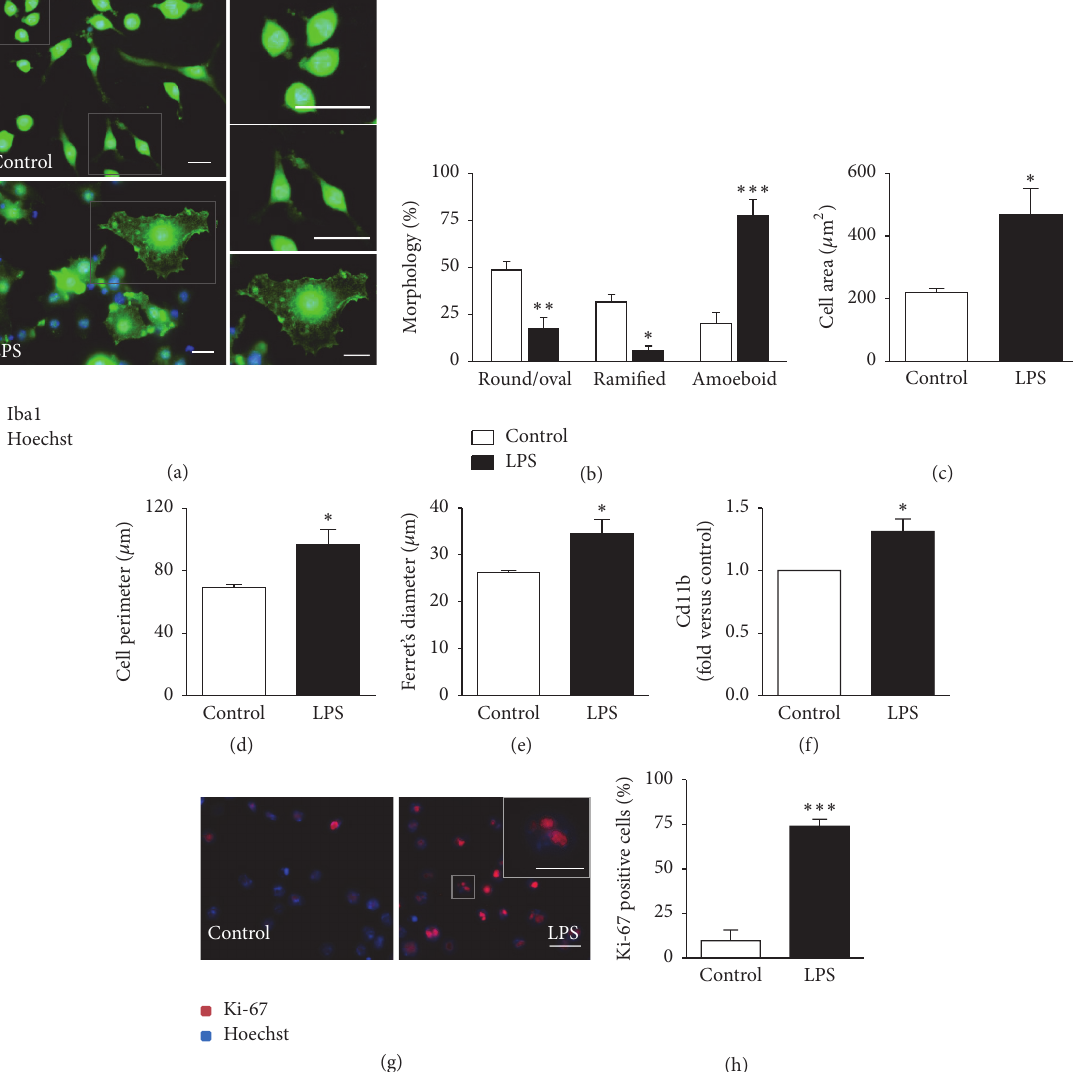
Figure 2: M1 polarized N9 microglia display amoeboid morphology, together with increased cell area, perimeter, and Feret’s diameter, while showing increased proliferation rate based on the high representation of CD11b and Ki-67 positive cells. Morphological analysis and detection of Ki-67 in the nucleus were performed by immunocytochemistry using anti-Iba1 and anti-Ki-67, respectively, as indicated in Materials and Methods. For morphology, representative results of one experiment are shown (a) and quantified as the percentage of cells with different morphologies, namely, round/oval, ramified, and amoeboid (b). Evaluation of cell area (c), perimeter (d), and Feret’s diameter (e) was performed using the computer program ImageJ. Cd11b expression was assessed by qRT-PCR (f). Representative results of Ki-67 immunostaining are shown (g) and expressed as the percentage of Ki-67 positive cells versus total number of cells (h). Results are mean ± s.e.m. from four independent experiments, except for Cd11b expression (f), where five experiments were performed. Comparison of more than two groups (b) was done by one-way ANOVA followed by multiple comparisons Bonferroni post hoc correction. Comparisons between lipopolysaccharide-treated (LPS-treated) N9 cells and nontreated cells (control) were made via two-tailed Student’s 𝑡 -test (f, h) or unpaired 𝑡 -test with Welch’s correction (c, d, e). ∗ 𝑝 < 0.05 , ∗∗ 𝑝 < 0.01 , and ∗∗∗ 𝑝 < 0.001 versus nontreated cells (control). Scale bar represents 20 𝜇 m (and 10 𝜇 m in the close-up shown inset in